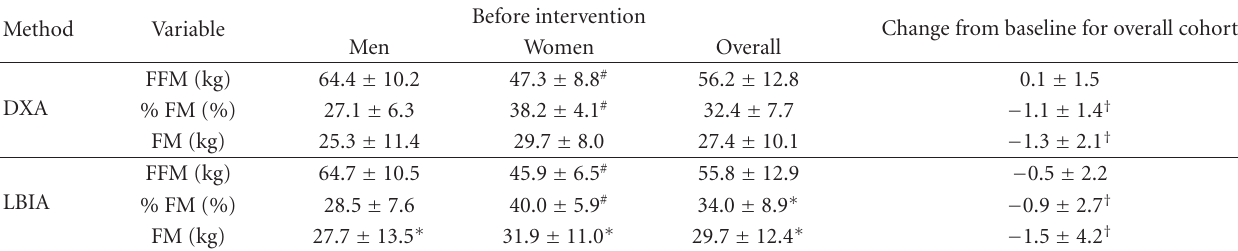
Table 2: Subject body composition by method at baseline and change from baseline for overall cohort (men = 23, women = 21, overall = 44).